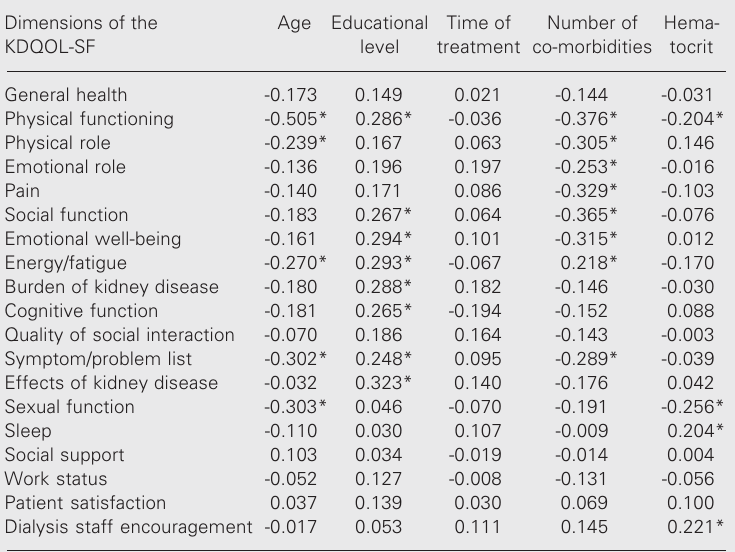
Table 3. Pearson’s correlation coefficients between the mean value of each dimension of the Brazilian Portuguese version of the Kidney Disease and Quality of Life - Short Form and the sociodemographic, clinical and laboratory parameters of the patients (N =